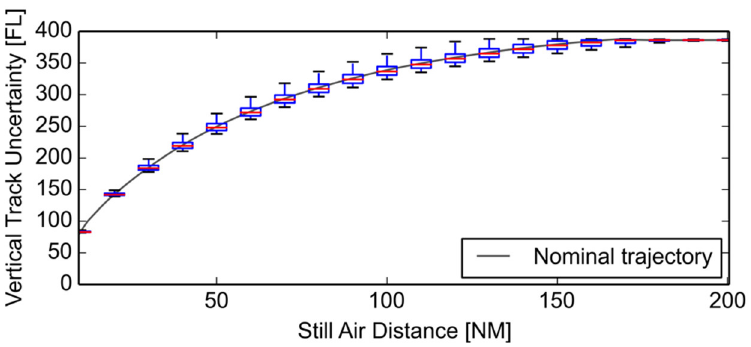
Figure 7. Climb profile of the nominal trajectory (grey) akin to the observed mean of VTU (red) of 11,000 simulation runs with Weibull distributed ATOM (blue).